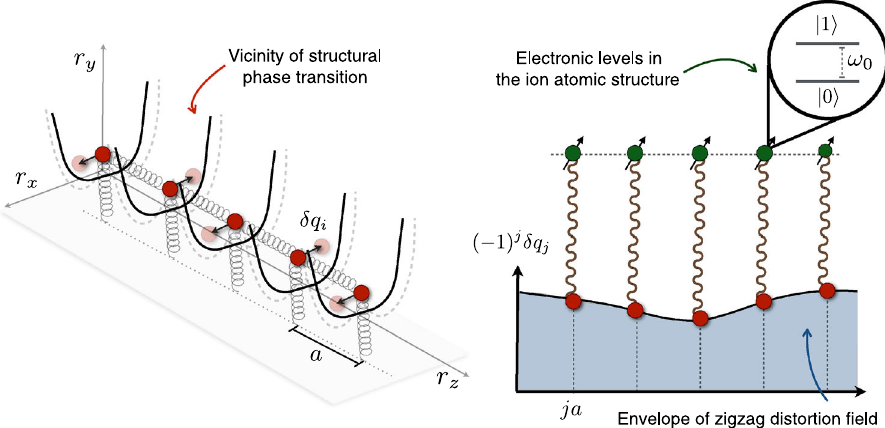
FIG. 3. Effective λϕ 4 QFT for ion crystals and quantum sensing scheme. Left: In the vicinity of the linear-to-zigzag structural phase transition of a trapped-ion crystal, the transverse zigzag vibrations yield the soft mode that contains the universal properties of the transition. Right: The slowly varying envelope of the zigzag distortion Eq. (32) allows us to develop a gradient expansion that leads to the effective λϕ 4 QFT. By exploiting two electronic levels of the ions, and a state-dependent dipole force Eq. (49), one can infer the generating functional of the